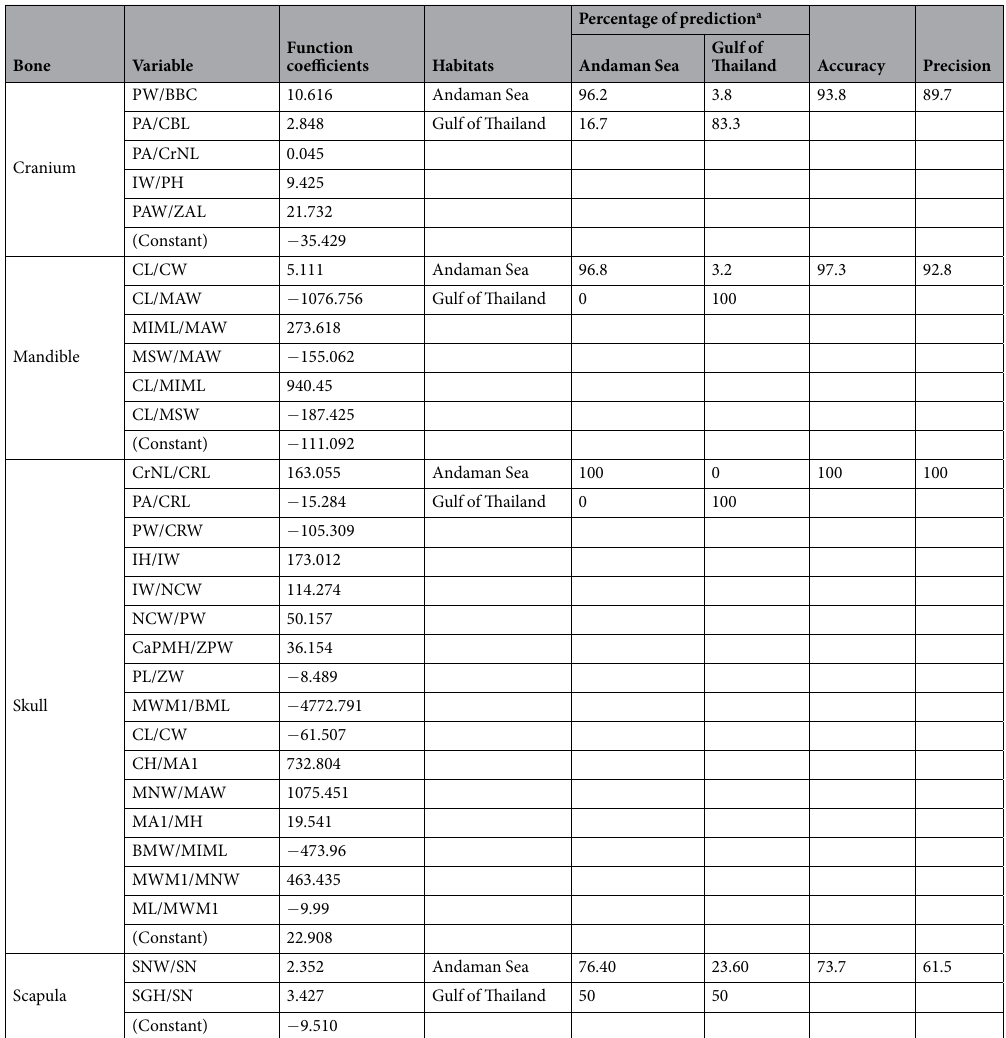
Table 7. Functions obtained from stepwise discriminant analysis based on the morphometrics of the cranium, mandible, skull and scapula, and classification results for predicting habitat. a Cross-validation is done only for those cases in the analysis. In cross-validation, each case is classified by the functions derived from all cases other than that